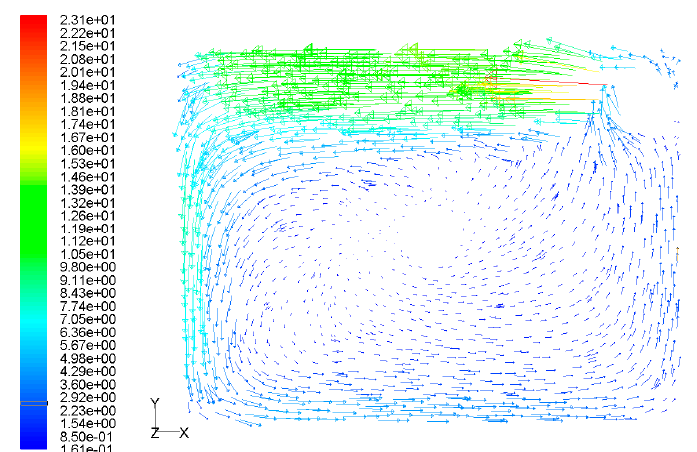
Figure 9. Airflow velocity vector 5 m away from the heading face